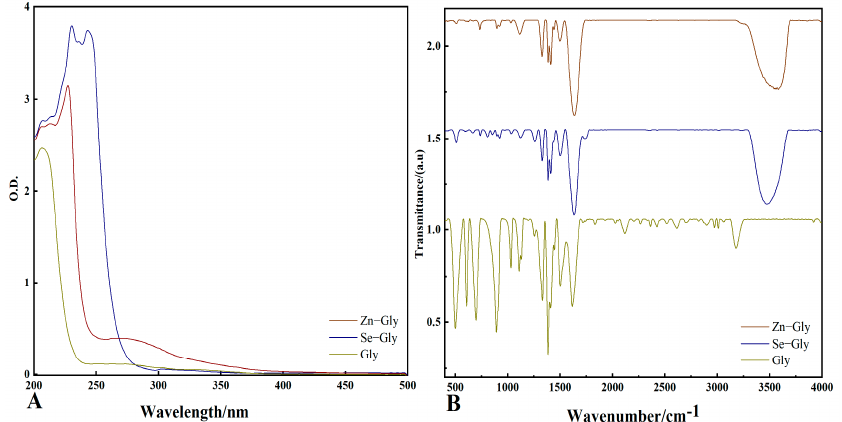
Figure 1. ( A ) UV scanning analysis of glycine − chelated zinc (Zn − Gly), glycine − chelated selenium (Se − Gly), and the standard glycine (Gly); ( B ) FT − IR spectra of Zn − Gly, Se − Gly, and the standard glycine (Gly).